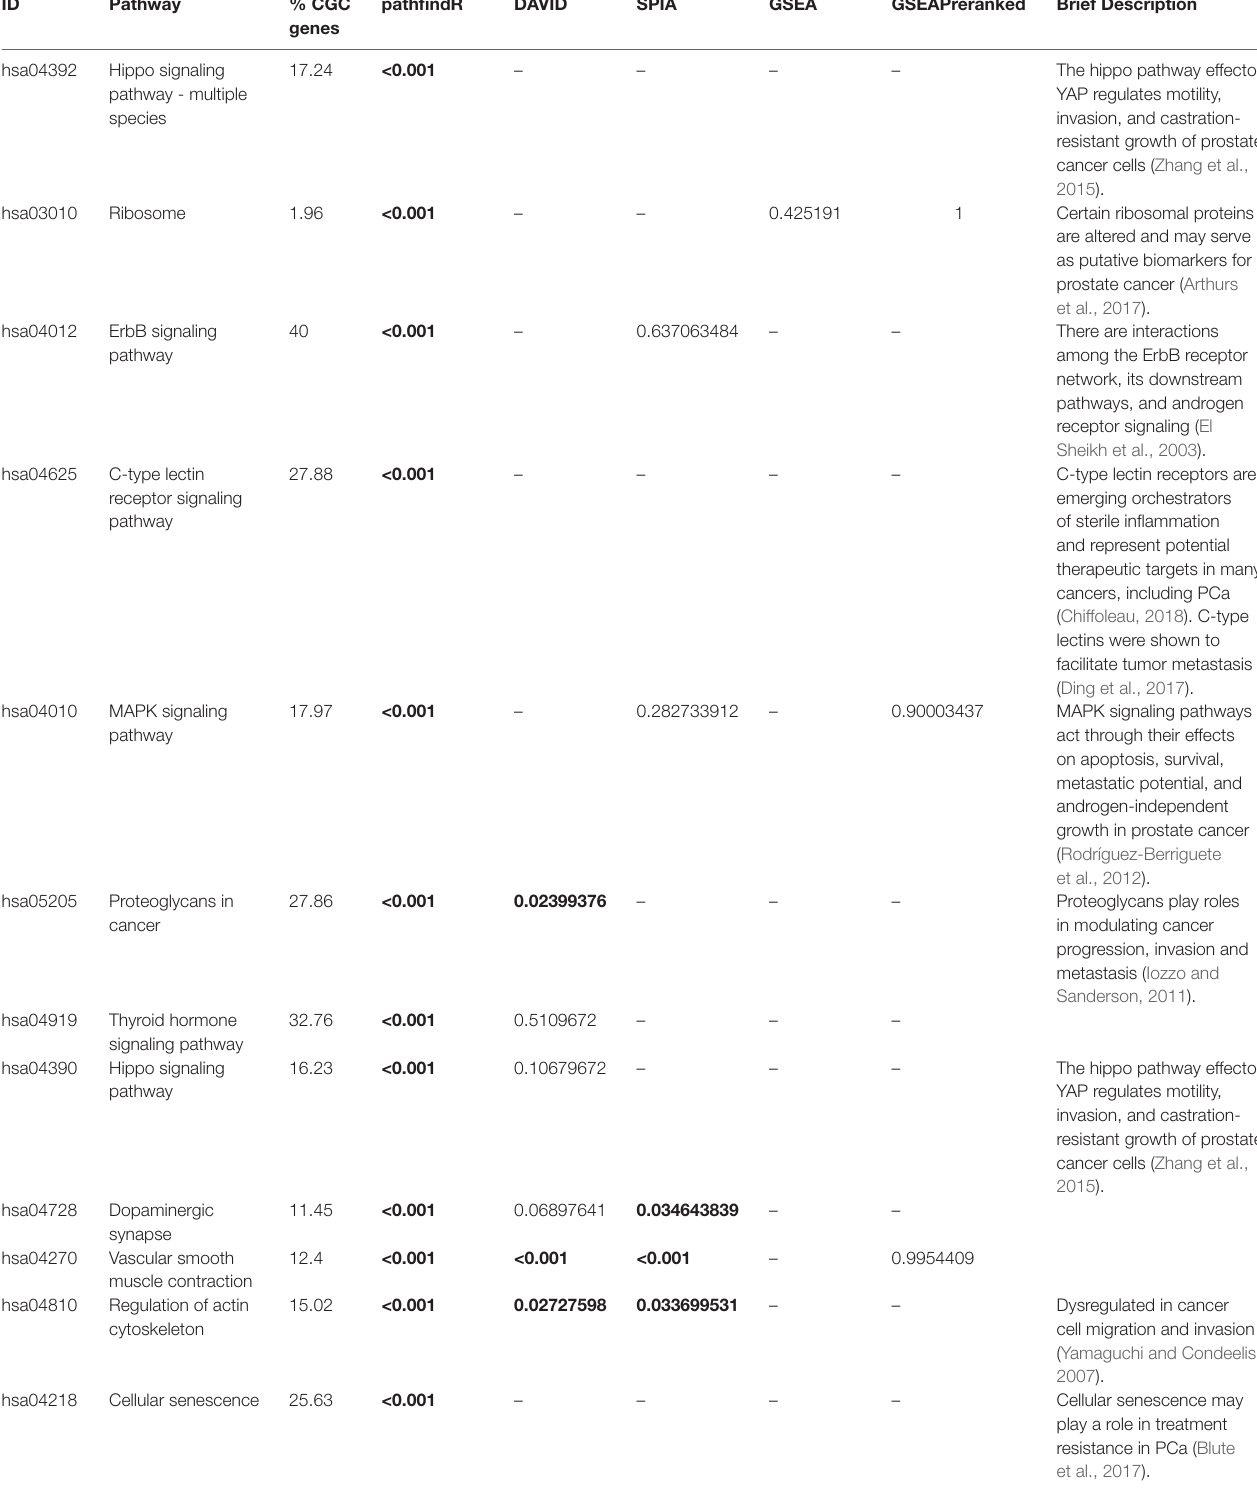
TABLE 3 | Pathway analysis results for the prostate cancer (PCa) dataset (adjusted p <